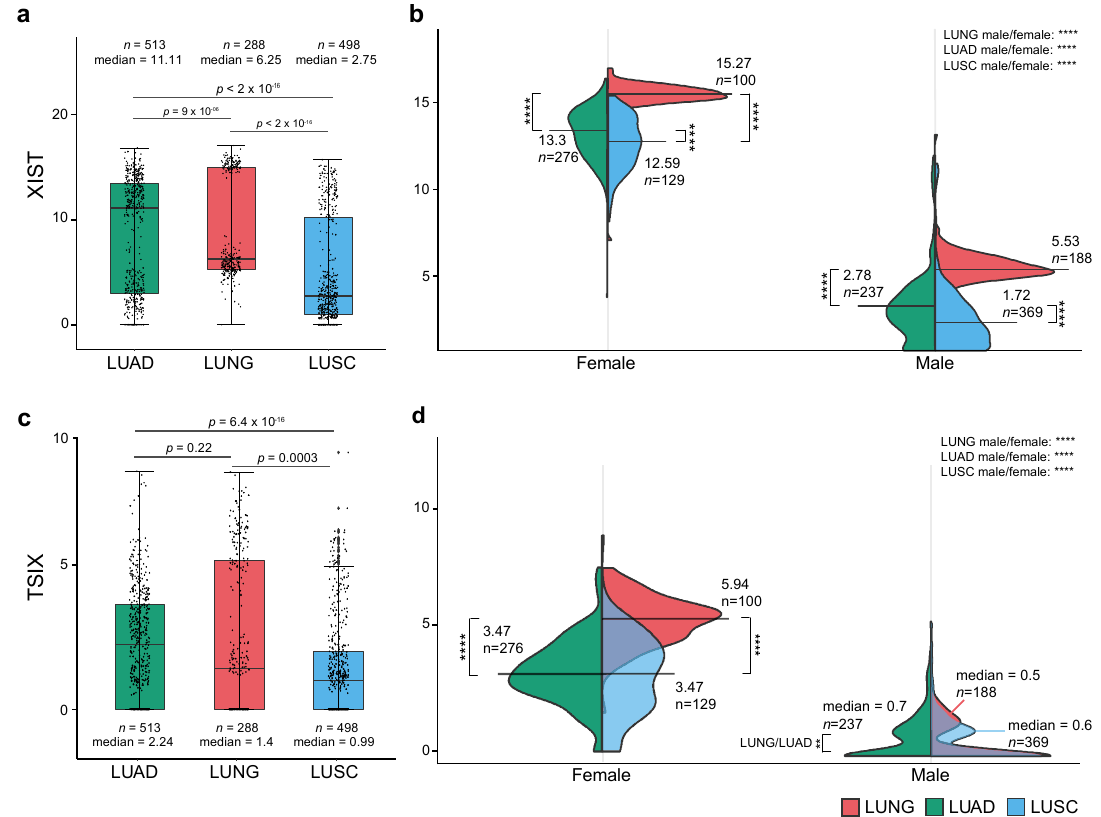
Figure 2. XIST and TSIX expression. ( a ) Boxplots of the overall XIST expression in LUAD, LUSC and normal lung (LUNG), ( b ) Violin plots of the gender-specific expression of XIST in LUAD, LUSC and LUNG, ( c ) Boxplots of the overall TSIX expression in LUAD, LUSC, and LUNG ( d ) Violin plots of the gender-specific expression of TSIX in LUAD, LUSC, and normal lung. All expression data is presented in units of log2(norm_count + 1). Median expression and total sample size (count, n) are shown. p -values were calculated the Wilcoxon test in R, statistically, significant represented as ****: p ≤ 0.0001, non-significant results are not labelled in the graph.